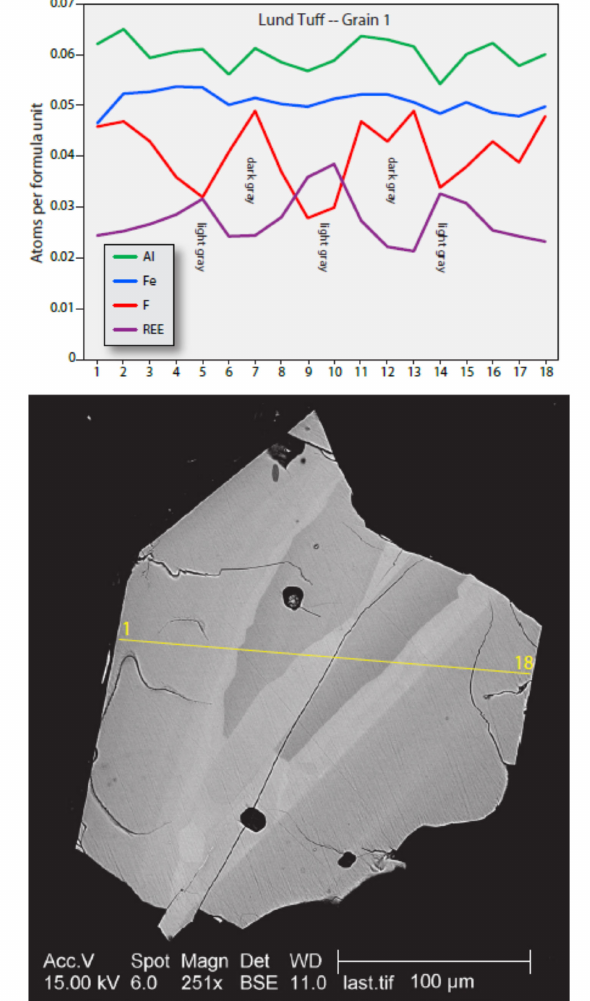
Figure 6. Al, Fe, F, and REE plotted along an EMP traverse (yellow line) for a titanite phenoclast from the Lund Tuff. The light gray zones in the backscattered electron (BSE) image are due mostly to variations in REE. F, on the other hand, is higher in the dark zones and lower in the bright